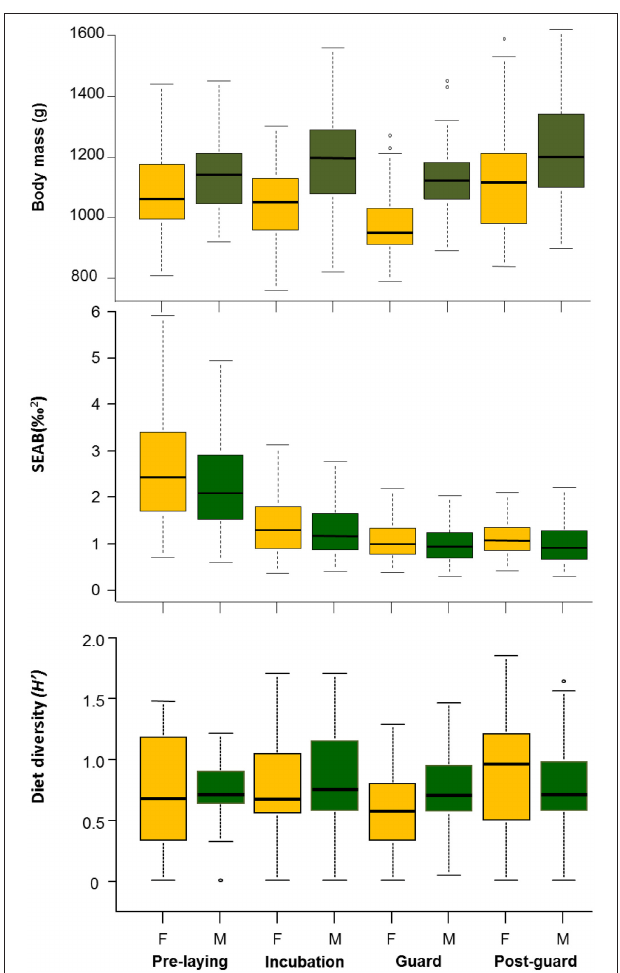
FIGURE 4 | Body mass from birds sample for blood and niche analysis [SEA B ( ‰ 2 )] estimated from 2003 to 2011 stable isotope data ( δ 13 C and δ 15 N, ‰ ). Diversity ( H’ ) values are from conventional data from 1985 to 2012 (not continuously see Table 1 ). Values are summarized by sex and breeding